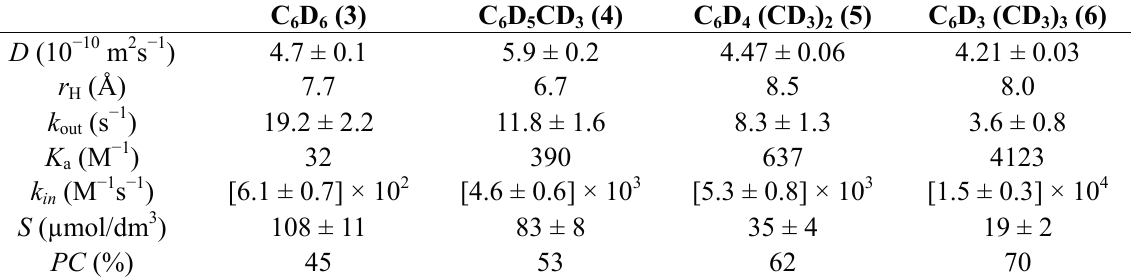
Table 1. Diffusion coefficients ( D ) of [ 1 – 2 ] complex were obtained from DOSY NMR (400 MHz) at 300.1 K and converted into hydrodynamic radii ( r ) using the Stokes-Einstein H equation. The exchange rate constants k ( s − 1 ) were obtained from 1 H, 1 H–EXSY NMR out (300.1 K) and are shown as mean ± standard deviation (>10 measurements).